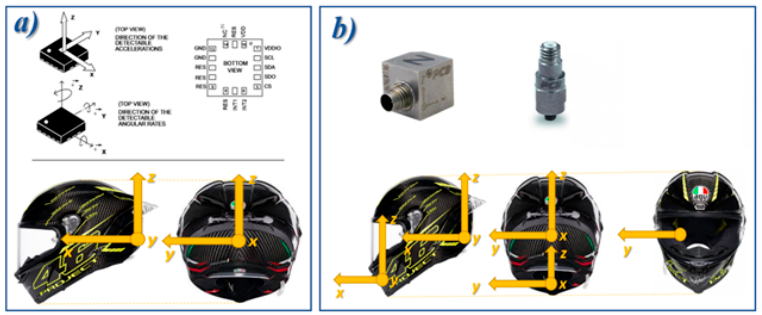
Figure 2. (a ) Reference system for tests A–B–C. ( b ) Reference system for test D. The helmet was aligned to the vertical axis, as shown in Figure 3 and Figure 4a.